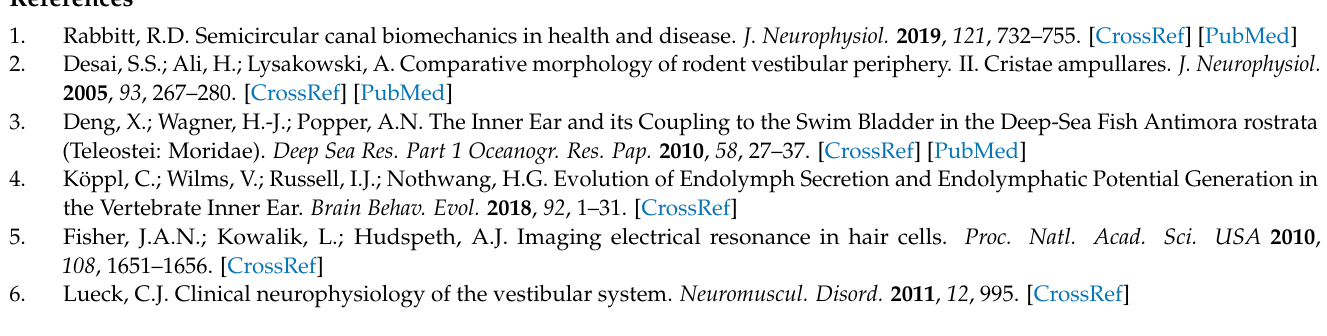
electrodes; Figure S4: The diagram of the assumed elastic structure for the membranous labyrinth of the semicircular canal; Figure S5: The stress relationship near the ampullary crest; Figure S6: The measuring system of the elastic modulus of the cupula; Figure S7: The displacement of the point of the thin film. The elastic modulus of the output charges when the bionic ampulla (BA) was deformed